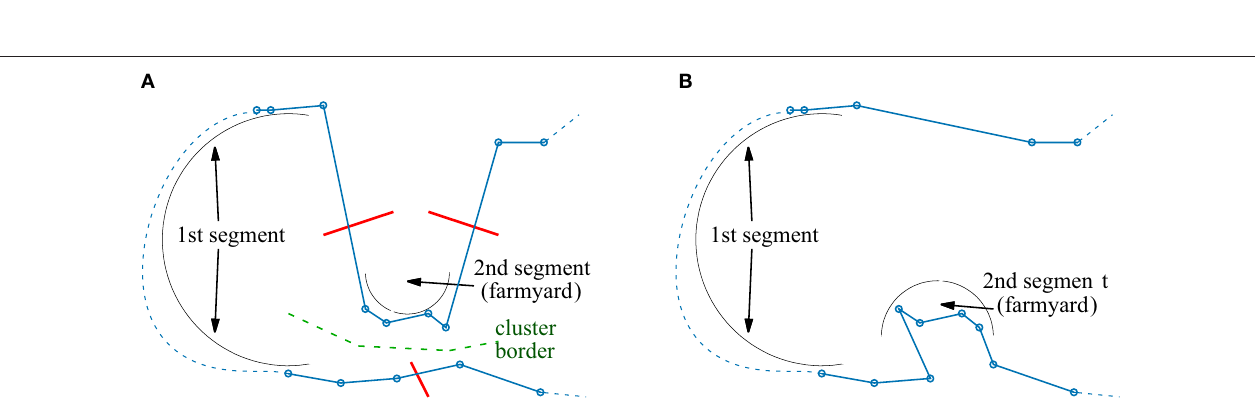
FIGURE 4 | Farmyard move: (A) unfavorable assignment of points to clusters; (B) correction using a 3-opt operation with exchange of segments and flip of 2nd segment.